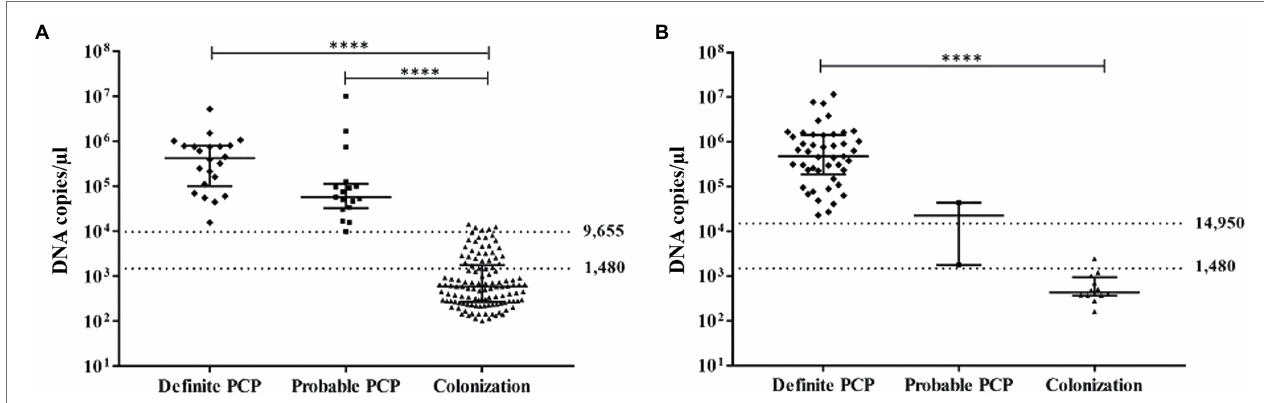
FIGURE 1 | Scatter plot showing P. jirovecii mtLSU-rRNA DNA copies/ μ l in bronchoalveolar lavage (BAL) samples among definite PCP, probable PCP, and colonization in non-HIV (A) and HIV (B) groups. Each symbol represents the number of DNA recovered from each patient. The horizontal bars represent the median values with IQR. The dot lines showed the upper and lower cut-off values in HIV and non-HIV groups. Analysis was performed using the non-parametric one-way ANOVA (Kruskal-Wallis) test. **** value of p